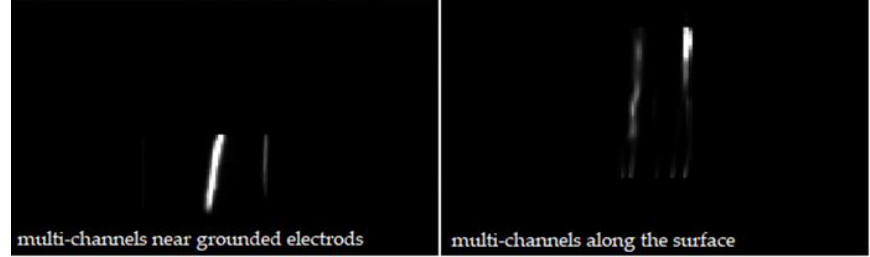
Figure 15. Multi-channel phenomenon.